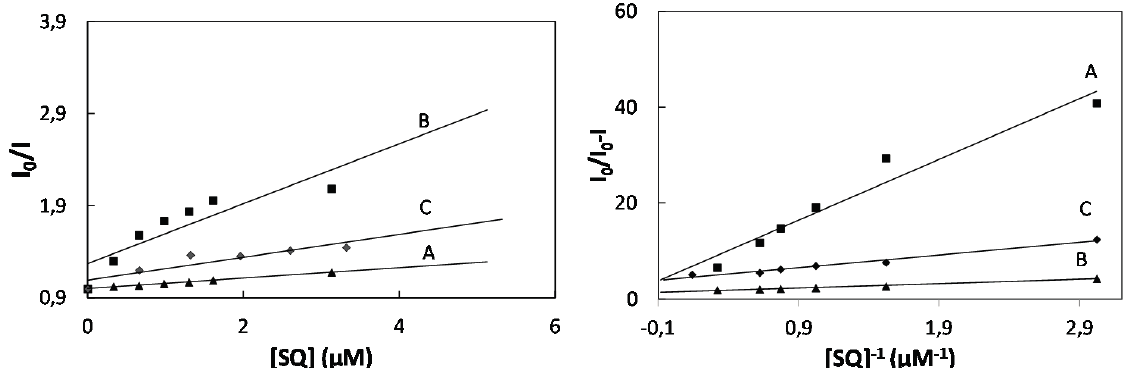
Figure 3. ( Left ) Stern-Volmer plot and ( Right ) Lehrer plot for the quenching of BSA by SQ6 (A), SQ7 (B) and SQ8